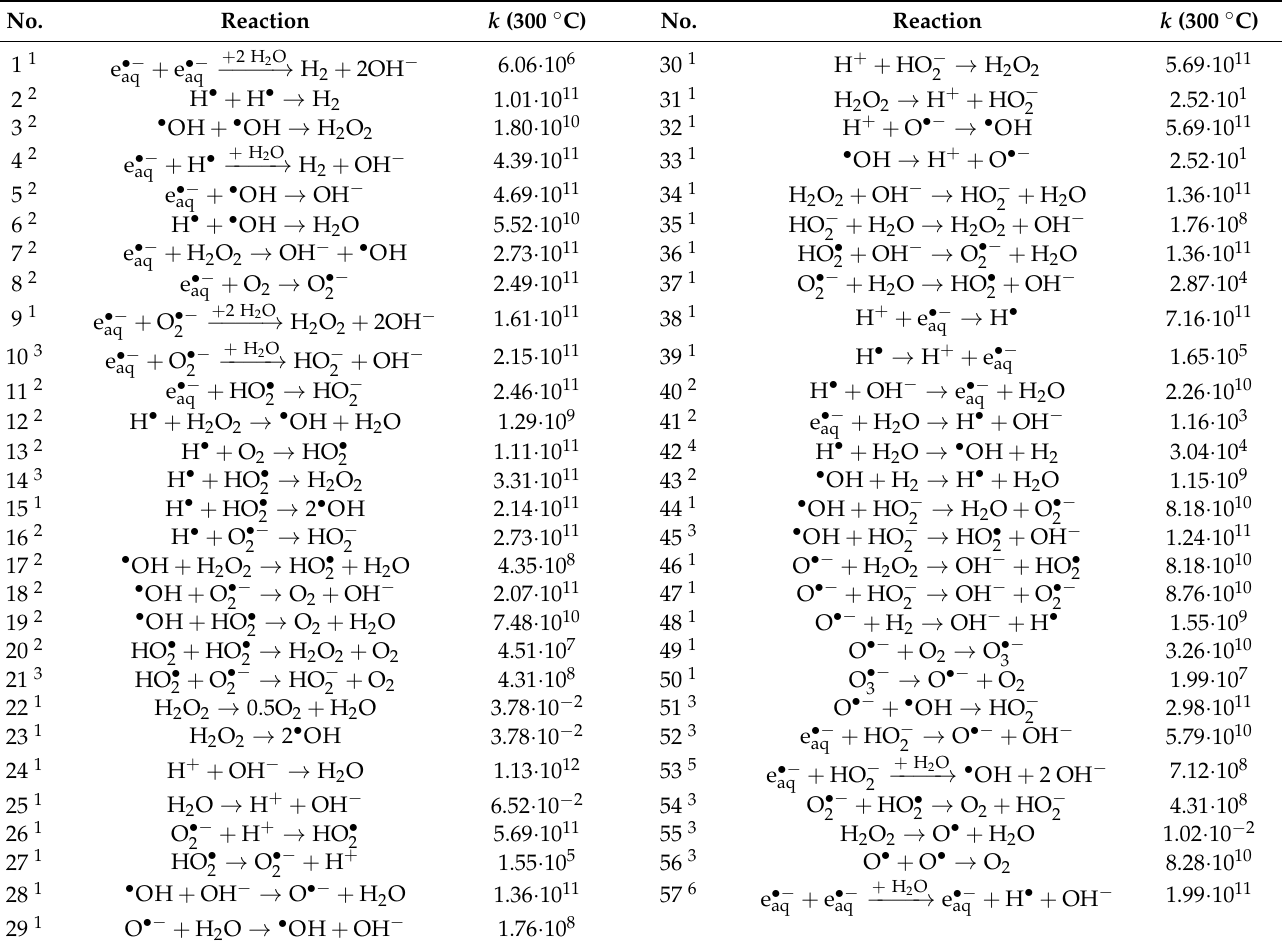
Table 2. Reaction set for the radiolysis of high temperature water and rate constants k at 300 ◦ C (units for 2nd and 1st order reactions are M − 1 · s − 1 and s − 1 , respectively). For reactions between similar species, the value of k , not 2 k , is